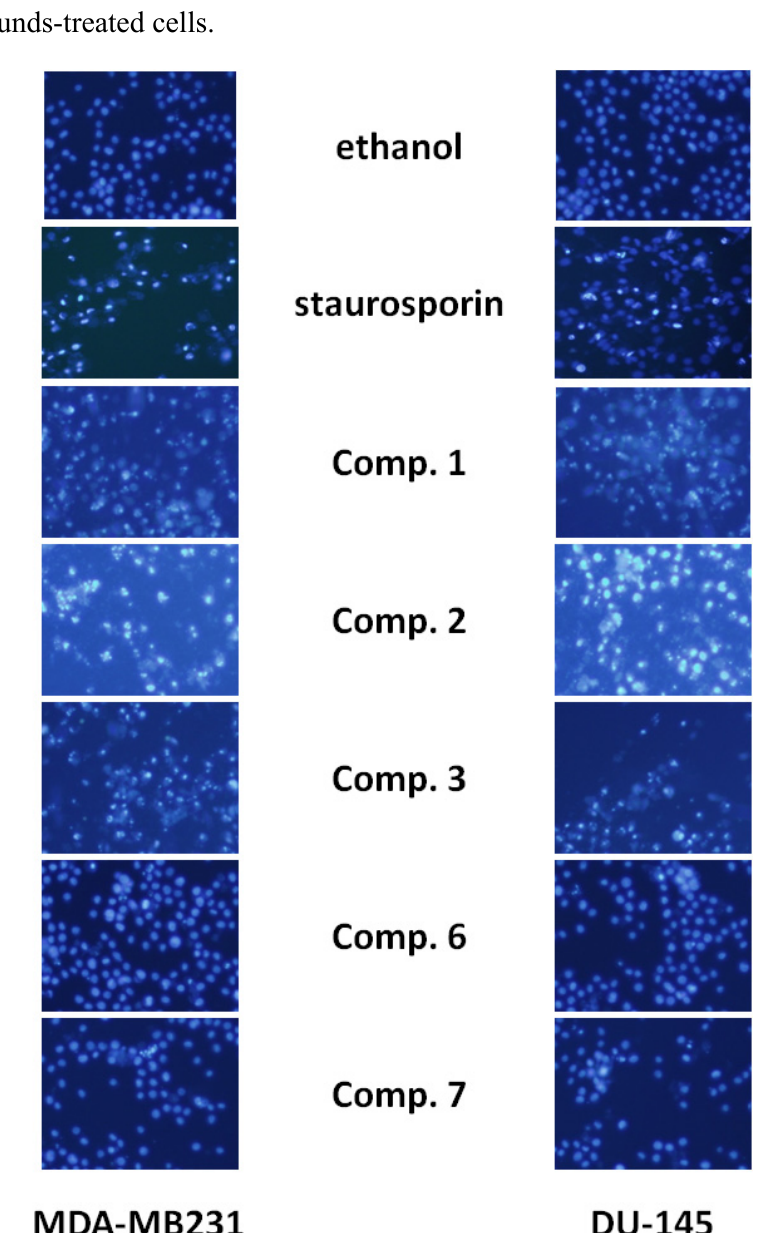
Figure 3. Effect of ent -labdanes on chromatin condensation and fragmentation. Compounds treated MDA-MB 231 and DU-145 cells were stained by Hoestch 33342